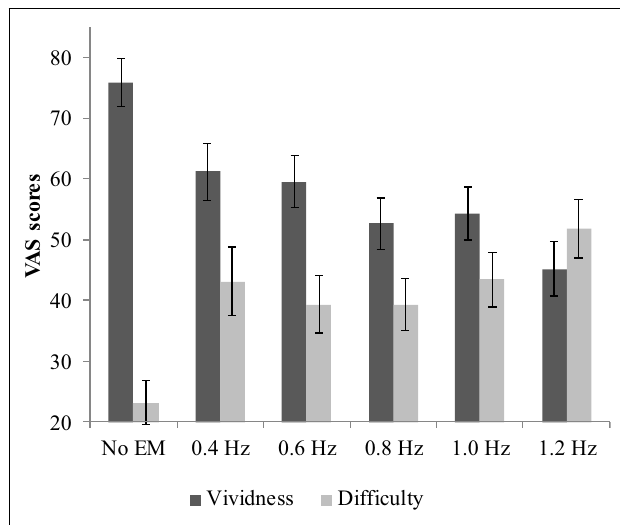
FIGURE 2 | MeanVAS scores and SEs for vividness and difficulty for the different speeds of EM and no EM .